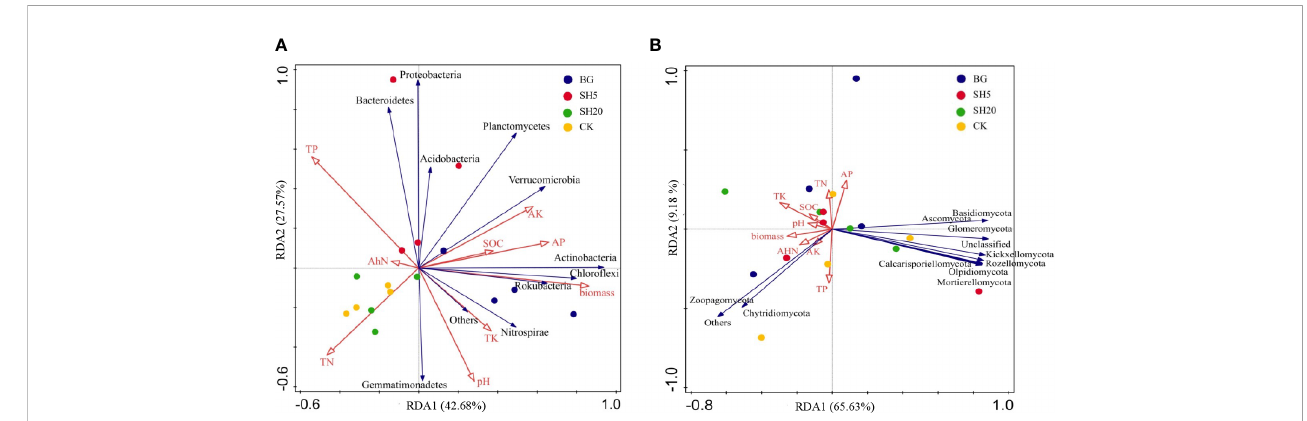
FIGURE 7 Redundancy analysis (RDA) of the correlations between soil microbial phylum ( A : bacteria; B : fungi) and soil-plant variables under four treatments (CK, BG, SH5, and SH20). Soil-plant variables include soils factors (soil pH, total P [TP], total N [TN], total K [TK], organic carbon [SOC], available P [AP], available K [AK], and alkali-hydrolyzed N [AhN]) and a plant factor (dry biomass).